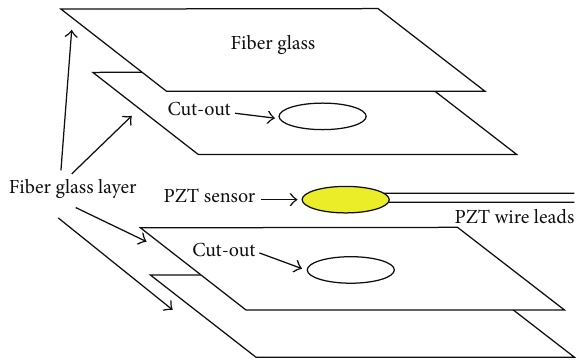
Figure 3: Schematic of the embedded piezoelectric into the com- posite by cut-out